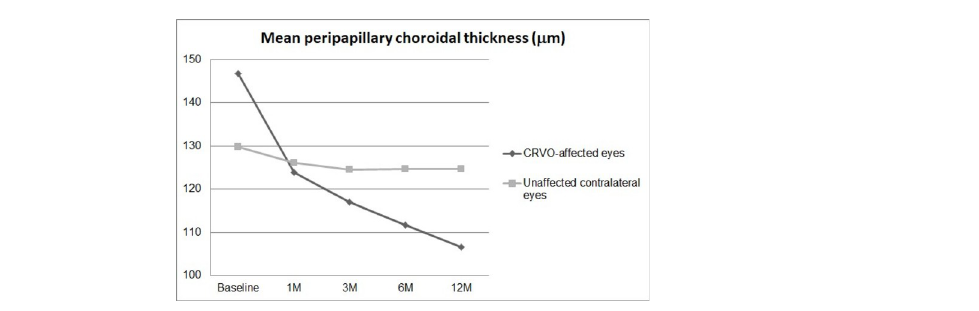
Changes of mean retinal nerve fiber layer thickness in the central retinal vein occlusion-affected eyes and unaffected contralateral eyes over 12 months The mean RNFL thickness of CRVO-affected eyes was 152.2 ± 49.1 μ m (85.0 to 243.0 μ m) at baseline and 107.3 ± 25.5 μ m (64.0 to 175.0 μ m) at 12 months (P = 0.006). The mean RNFL thickness of unaffected contralateral eyes was 97.1 ± 14.7 μ m (71.1 to 159.0 μ m) at baseline and 99.3 ± 13.3 μ m (76.0 to 126.0 μ m) at 12 months (P = 0.406). Notably, the mean RNFL thickness was significantly thicker in CRVO-affected eyes than in contralateral eyes at baseline (P < 0.001), 1 month (P = 0.001), and 3 months (P = 0.013). However, we saw no significant difference at 6 months (P = 0.068) and at 12 months (P = 0.140), although the mean RNFL thickness at these time points was still greater in CRVO-affected eyes than in contralateral eyes. Fig 5 shows changes observed in mean RNFL thickness.